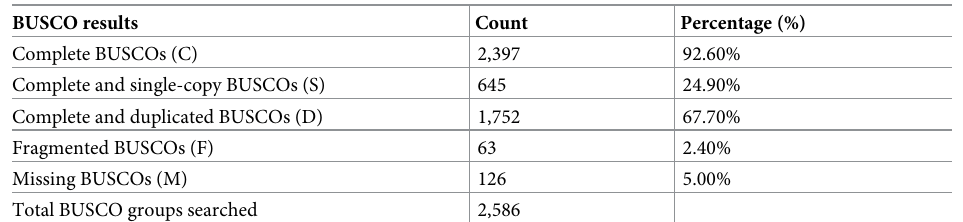
Table 1. Description of the BUSCO